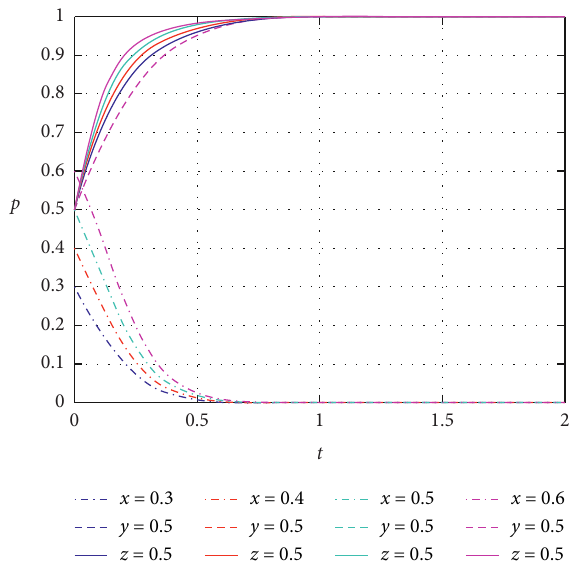
Figure 3: Evolution result of change of initial willingness to participate x .